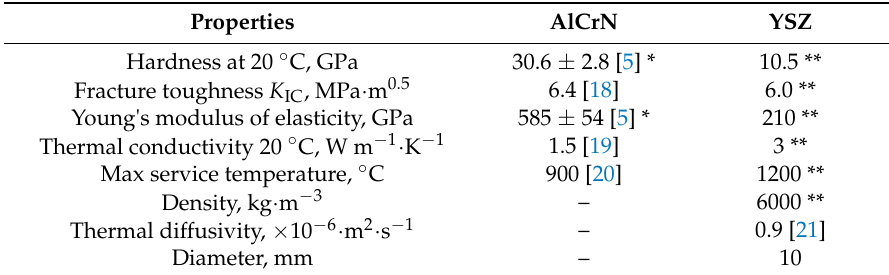
Table 1. Properties of coating and ball materials.